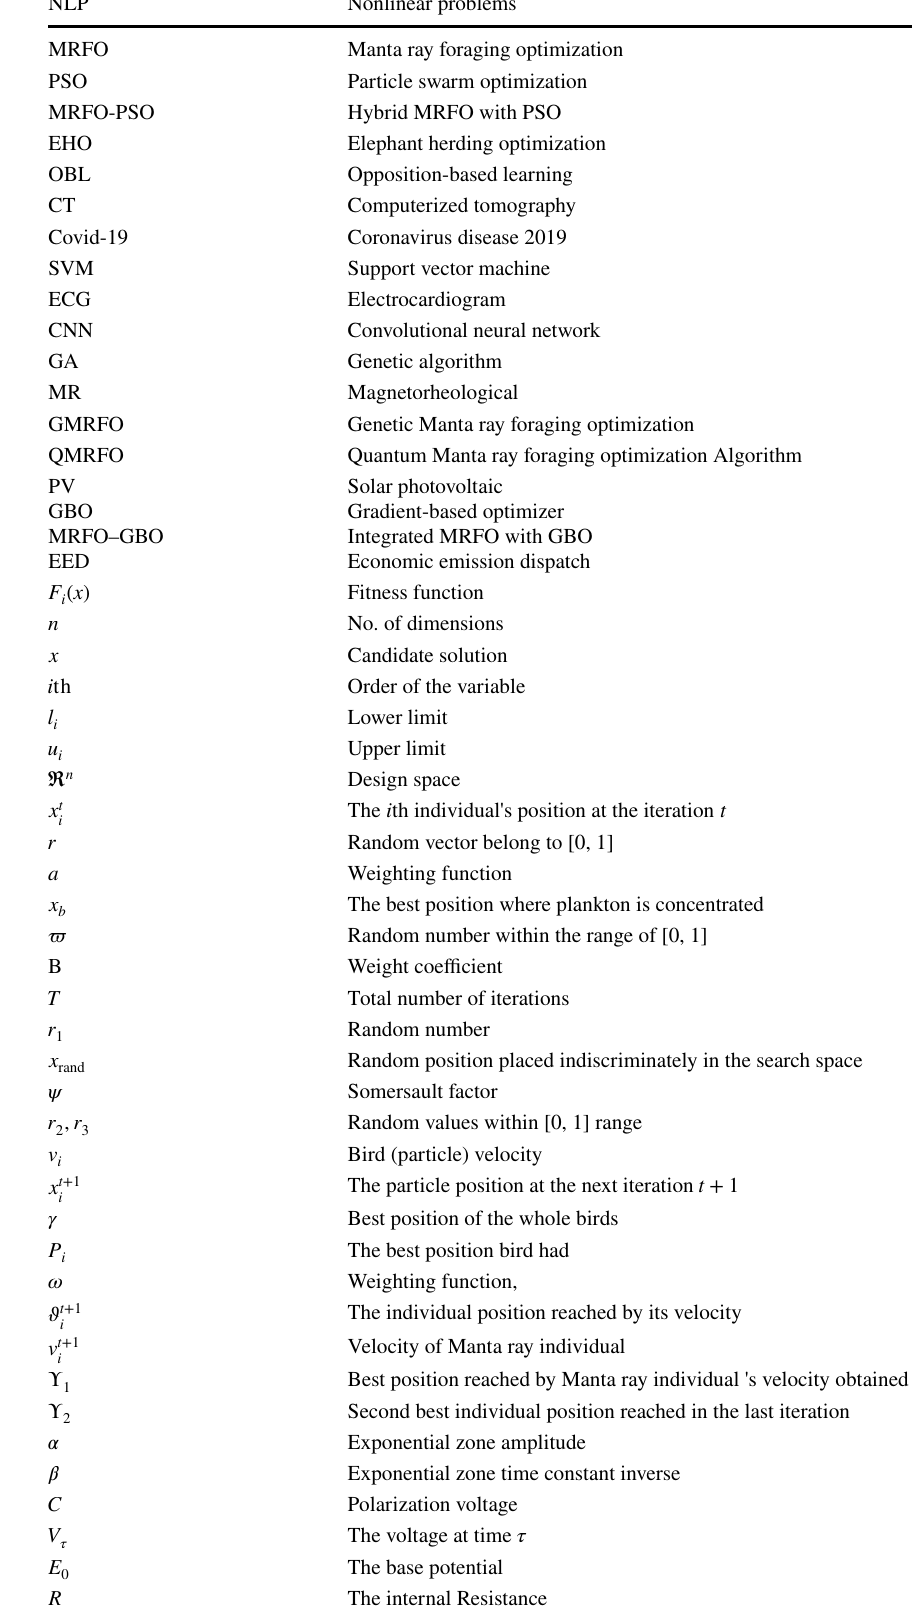
Table 11 The abbreviations and symbols used in this